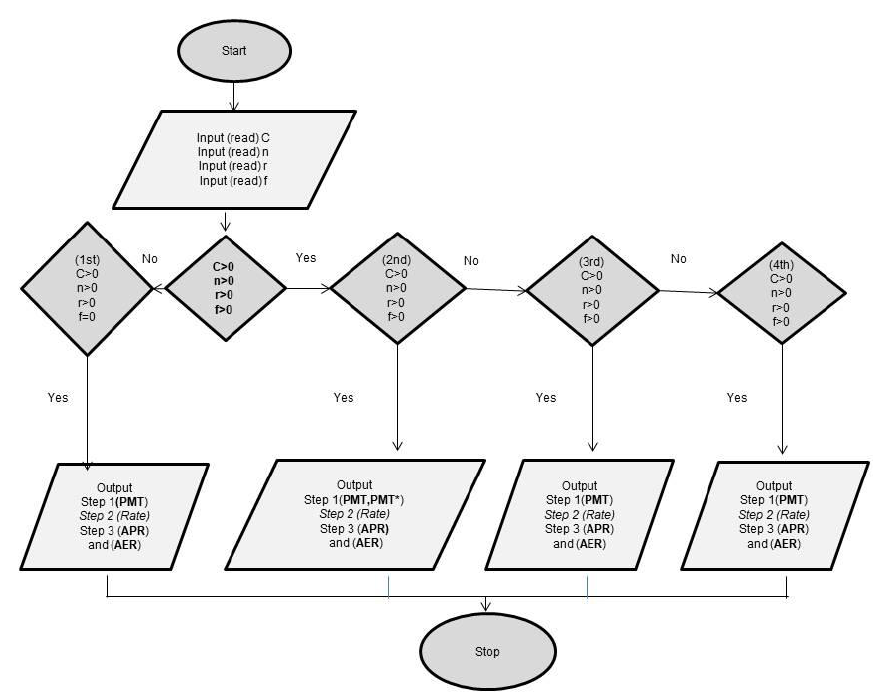
Figure 1. The algorithm for a system that supports the transparency of consumer credit offers. Figure 1 Legend. C—Capital, amount of credit / loan. n—number of repayment (usually monthly). r—interest rate (usually annual). f—additional fee (usually given as an interest rate / percentage of